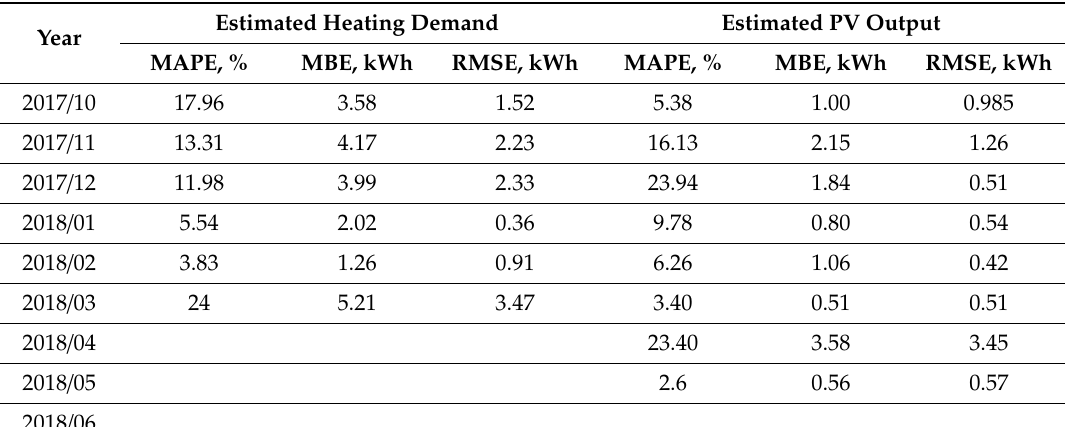
Table A3. The MAPE, MAE, and RMSE of estimated heating demand and PV